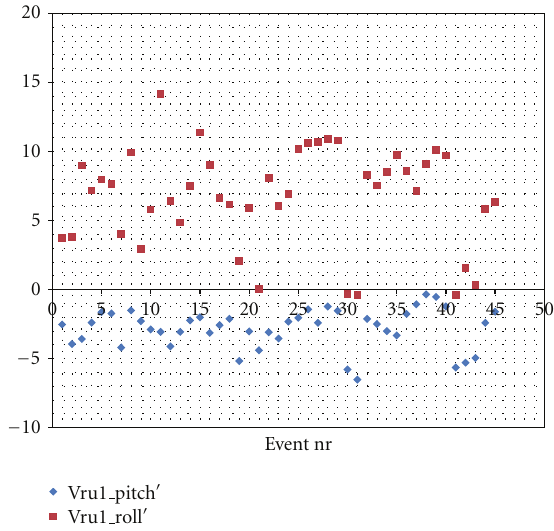
Figure 23: Ship Motions during the events—port